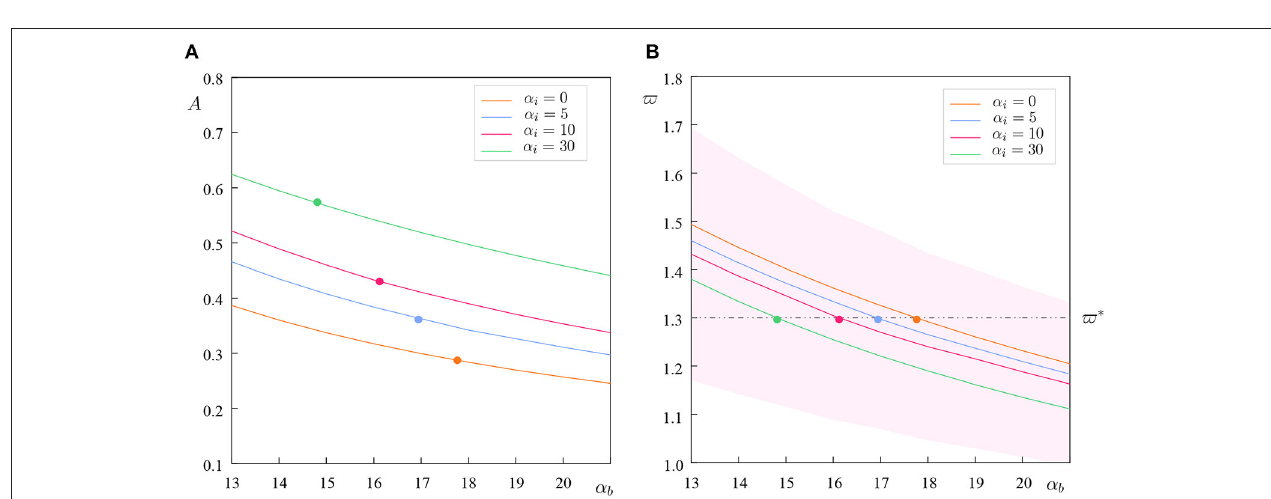
FIGURE 11 | Dispersion spectrum of the tetrachiral material: (A) full band gap amplitude A and (B) center frequency ̟ vs. the ligament-to-ring mass ratio α b for different filler-to-ring mass ratios α i .